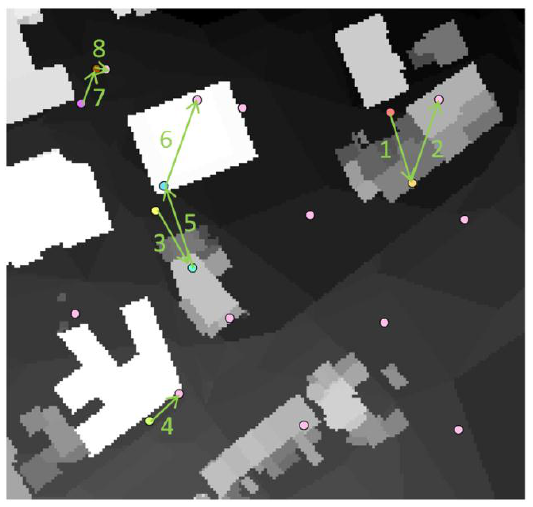
Figure 10. Sensor movement simulation of the context-aware optimization algorithm.